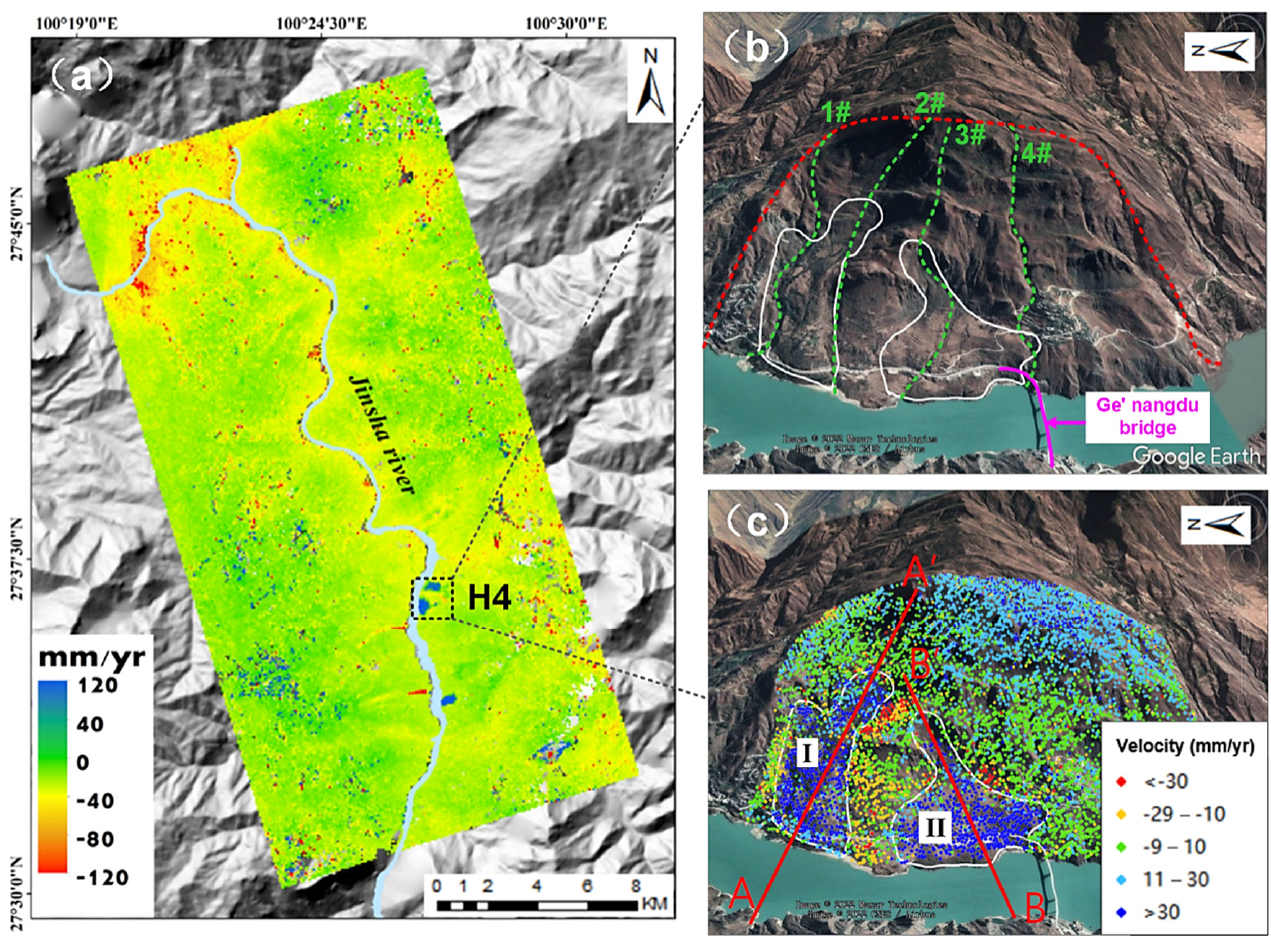
Figure 11. Deformation rate of the XJ landslide mass obtained using DS-InSAR technology and a corresponding optical image. ( a ) is the deformation rate of DS-InSAR, ( b ) is the location of cracks 1#, 2#, 3# and 4#, and ( c ) is the local enlarged view of H4.